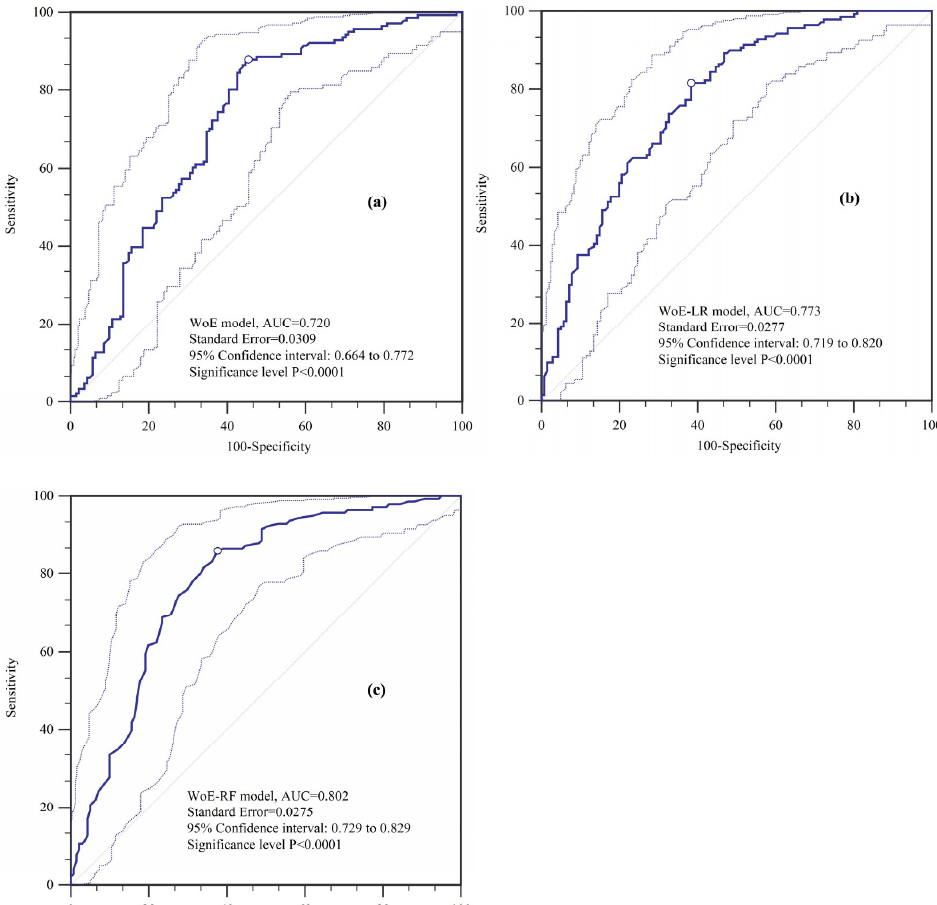
Figure 7. Landslide susceptibility map using the WoE-RF model.